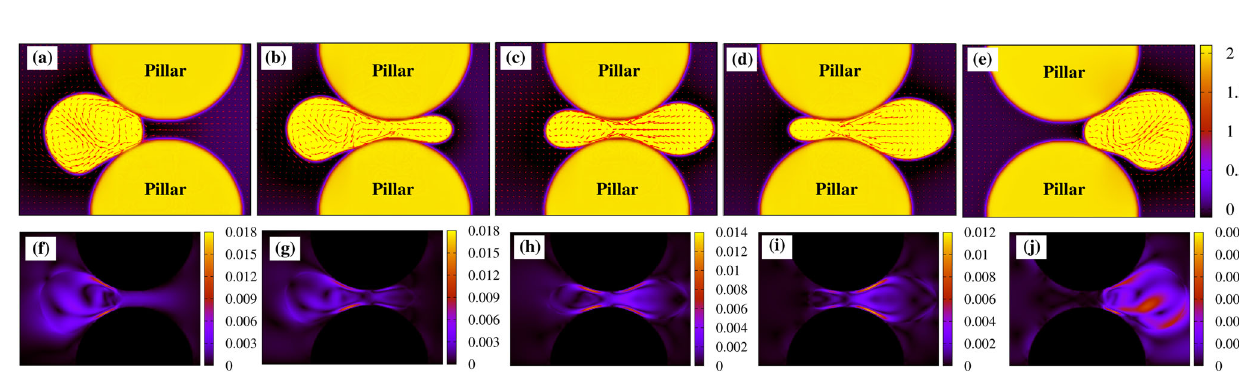
still prevails ( c ). Once the droplet leaves the pore, the double vortex gradually recovers,initiallycon fi nedatthefront( d )andafterwardspreadwithinthebulk( e ). Once again, the magnitude of v remains high especially near the surfaces of the pillars( f – i ),whilesubstantiallydiminishingasthedropletleavestheconstriction( j